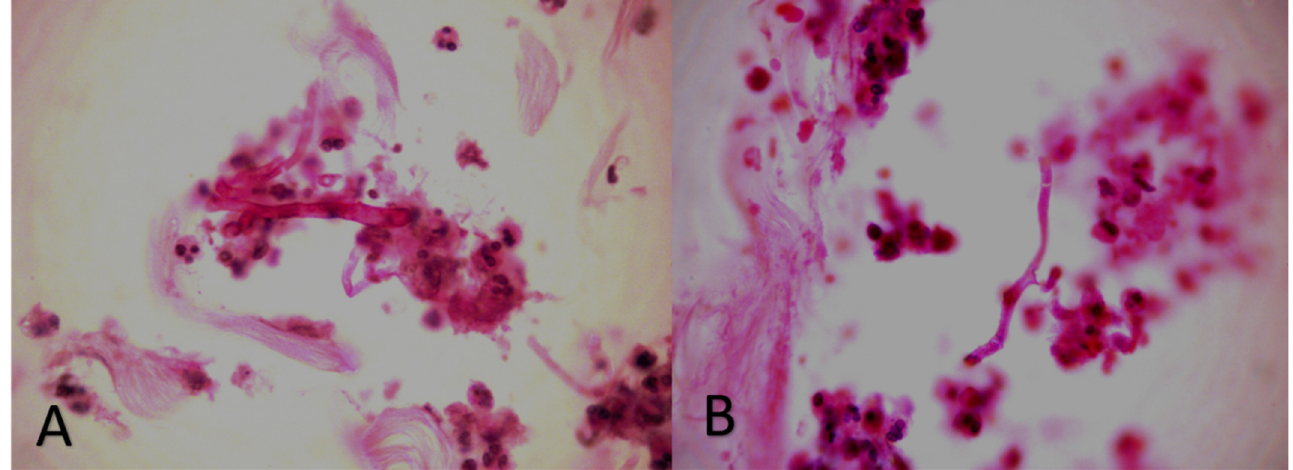
Figure 3. Histopathological examination: intense inflammatory infiltration consisting of neutrophils with many ( A ) hyalines, branched, aseptate hyphae presumptive Mucorales and ( B ) hyalines, branched, septate hyphae, presumptive hyphomycetes other than Mucorales (stain: haematoxylin-eosin, magnification: × 40).